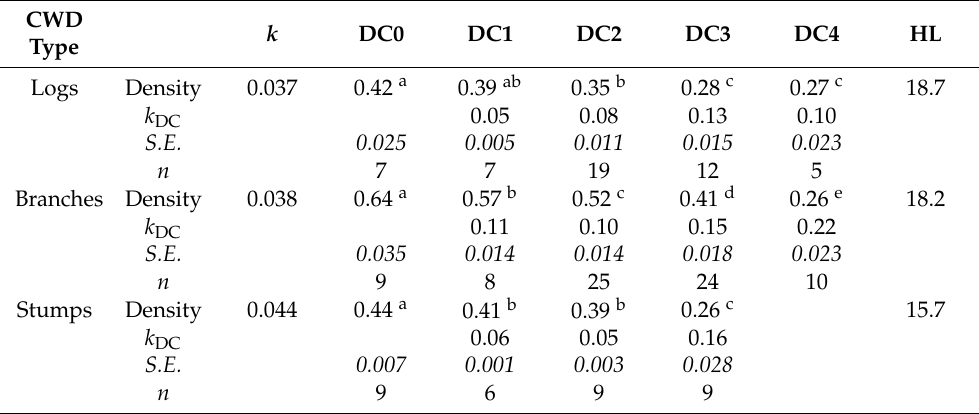
Table 4. Mean densities (g cm − 3 ) with associated standard error (S.E.) (in italics) and sample sizes (n) for log, branch, and stump samples by DC. The parameter k represents the estimated decomposition rate of windrowed Sitka spruce WD, while k DC is the DC-based decomposition rate (Equation (3). Half-life (HL) is the time taken (in years) for 50% of the material to decompose (years). The superscripted letters present the results of analysis of variance (at the 95% level). Observations with a different letter were significantly